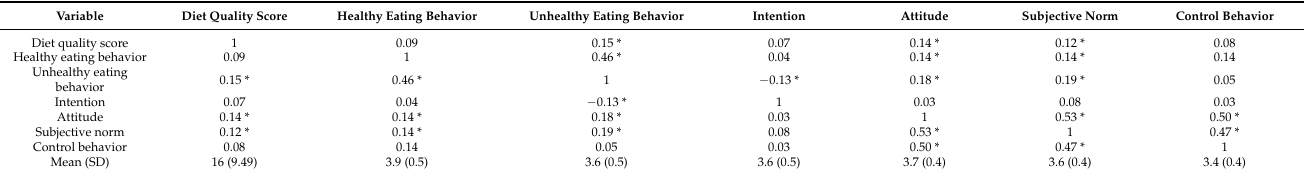
Table 3. Correlation between eating behavior constructs based on the Theory of Planned Behavior and diet quality among